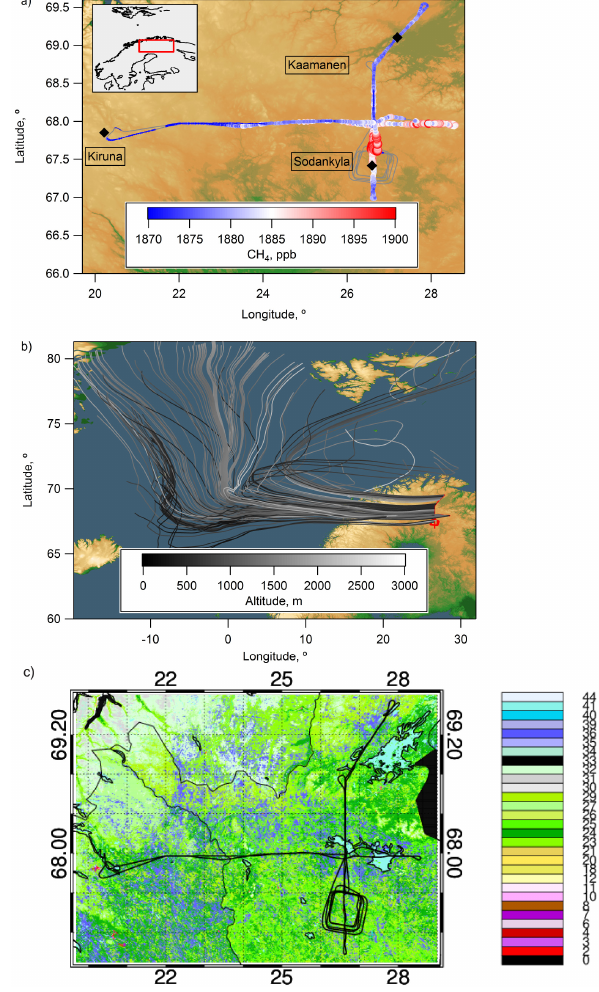
Figure 1. (a) FAAM BAe-146 flight track for flight B720 (22 July 2012). Observations of CH 4 in the PBL are coloured according to the legend. Black diamonds mark Kiruna, Sodankylä and Kaama- nen. (b) Five-day HYSPLIT back trajectories that were started ev- ery minute along the FAAM BAe-146’s flight track when it was within the PBL. (c) Flight track where the surface is coloured using the land use type (CORINE land cover 2006). Numbers correspond to land types given in Table